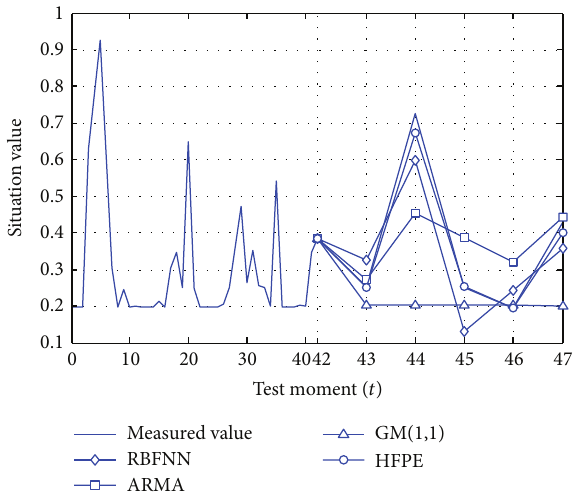
Figure 6: Prediction results of network attack situation.